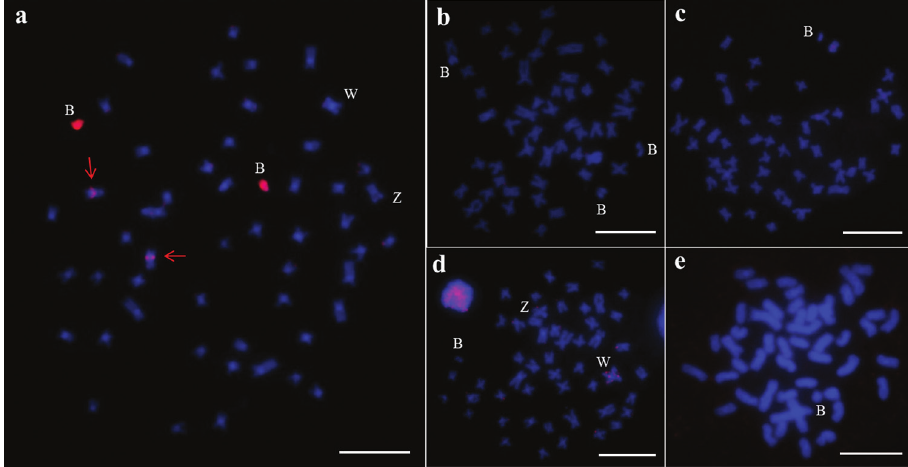
Figure 3. Cross-species chromosome painting. CaB probe in Characidium alipioi ( a ), C. gomesi ( b ) and C. oiticicai ( c ) and with the CgB ( d ) and CoB ( e ) probes in C . alipioi